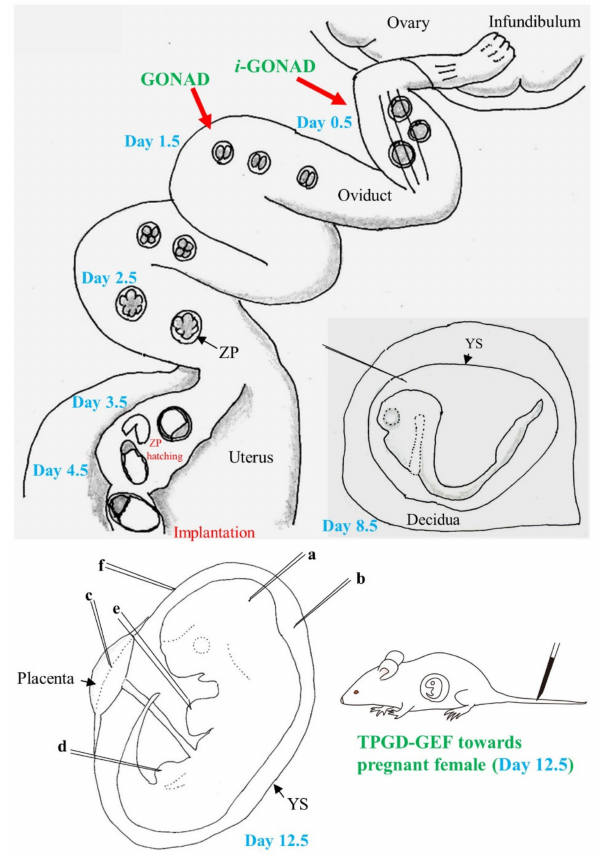
Figure 1. Schematic representation of preimplantation (days 0.5 to 4.5; day 0 of pregnancy is defined as the day a vaginal plug is found) and postimplantation (days 5.5 to 9.5 and 11.5) development of mice: During the preimplantation stage, zygote (1-cell embryo) (at day 0.5), 2-cell embryo (at day 1.5), 8- to 16-cell embryo (at day 2.5), early blastocyst (at day 3.5), and late blastocyst (at day 4.5) float in the oviductal lumen or uterine horn. Embryos at days 0.5 to 4.5 have zona pellucida (ZP), but embryos at day 4.5 begin to escape from ZP, which is called “ZP hatching”, and form early egg cylinder containing epiblast after implantation. In vivo genome editing is possible after intraoviductal instillation of a solution containing the genome-editing components and subsequent in vivo electroporation (EP), known as the “genome-editing via oviductal nucleic acids delivery (GONAD)” (for 2-cell embryos) and “improved GONAD ( i -GONAD)” (for zygotes) techniques. On day 8.5, embryos commence somite formation with the formation of blood-island and a beating heart. Furthermore, closure of neural tube commences. Notably, embryos at days 5 to 8 are surrounded by decidua, which does not allow visualization of embryos upon surgical dissection of the uterus. Transfection of day 8.5 embryos is possible when a nucleic acid-containing solution is injected into the internal portion of decidua through the yolk sac (YS) using a micropipette. On day 12.5, the fetus (embryo) is visible through the YS upon surgical dissection of the uterus under a dissecting microscope. Thus, it is possible to administer intrabrain ( a ), intraamniotic ( b ), intraplacental ( c ), intramuscular ( d ), intracardiac ( e ) and intravitelline ( f ) injections using a micropipette for in utero gene delivery. Tail-vein injection of a solution containing genome-editing components into pregnant female mice is also a useful in vivo approach to induce genome editing in day 12.5 fetuses, which is called “transplacental gene delivery for acquiring genome-edited fetuses